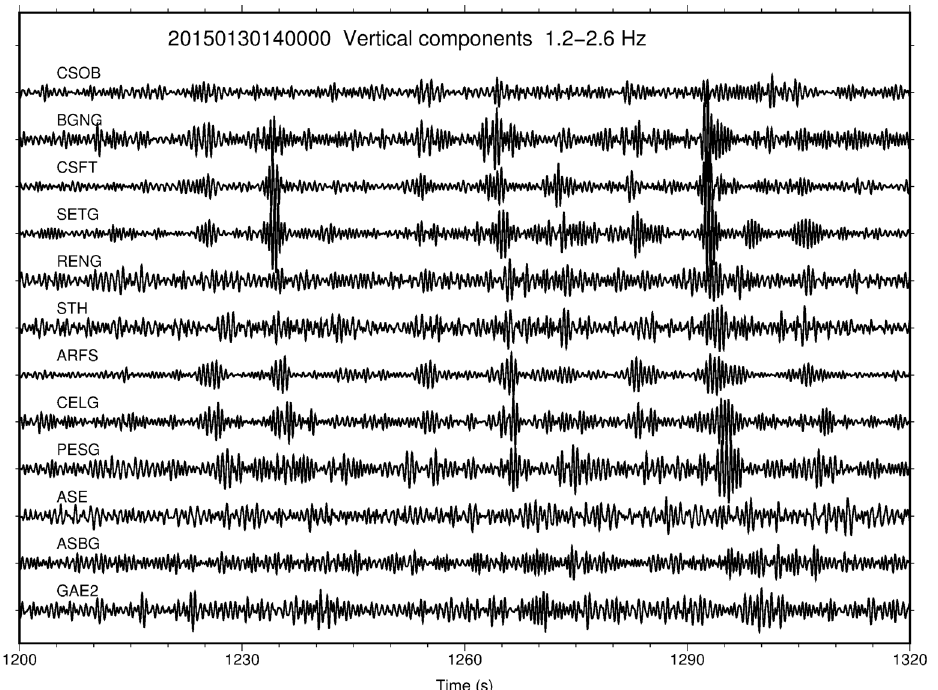
Figure 8. Vertical component seismograms of many seismic stations in the central area of Campi Flegrei caldera showing the tremor sig- nals recorded on January 30, 2015. Signals have been bandpass filtered between 1.2 Hz and 2.6 Hz to improve the signal to noise ratio. ARFS is the signal obtained by stacking ARF array